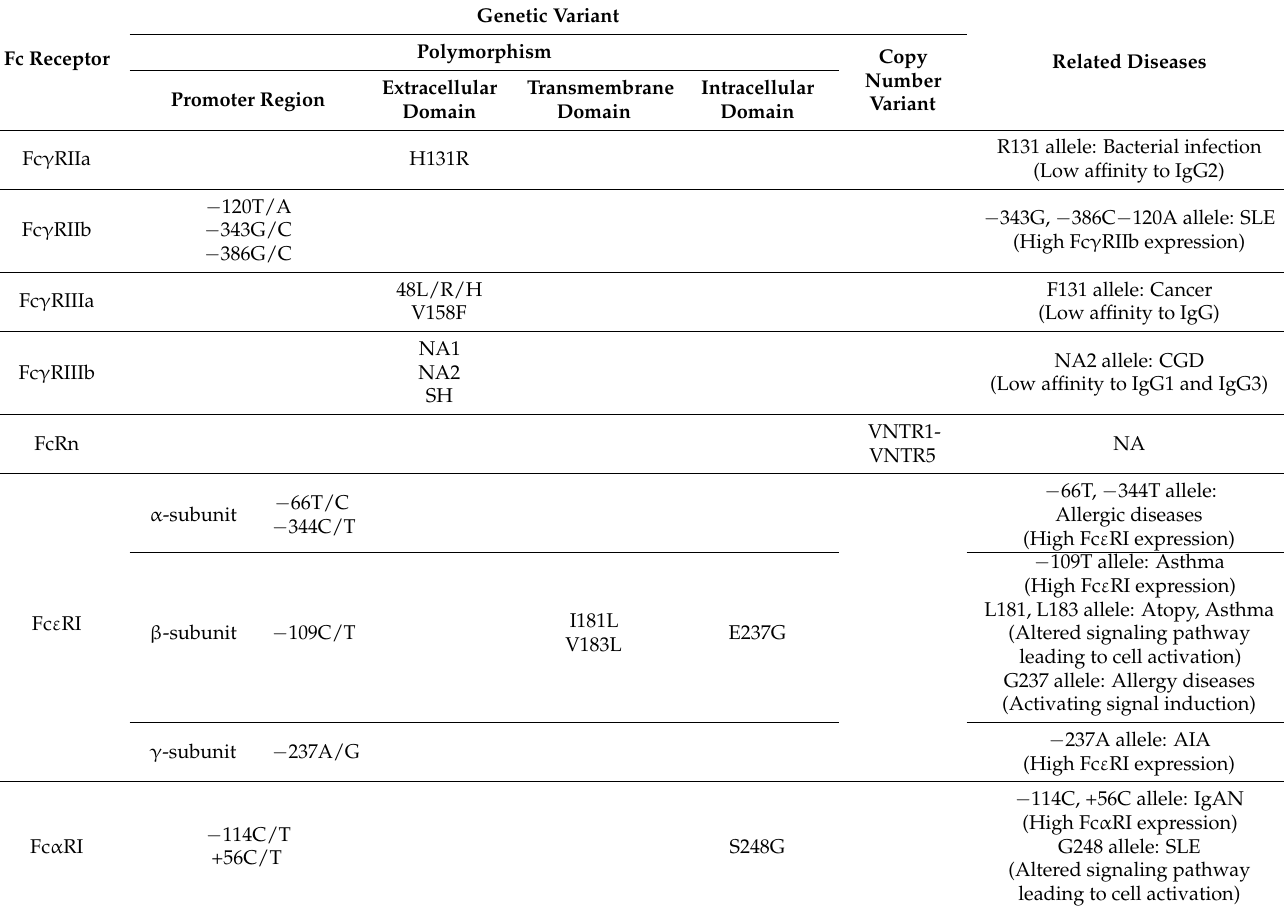
Figure 1. Polymorphisms influence gene expression. Polymorphism in the promoter region induces differences in promoter activity and therefore changes the expression level of Fc receptors. − 386C − 120A and − 343G of FCGRIIB increase the expression level of Fc γ RIIb. − 66T and − 344T of FCERIA, − 109T of FCERIB, and − 237A of FCERIG increase the expression level of α , β , and γ subunit, respectively. − 114C and +56C of FCAR increase the expression level of Fc α RI. Table 2. Summary of genetic variants of individual FcRs and related